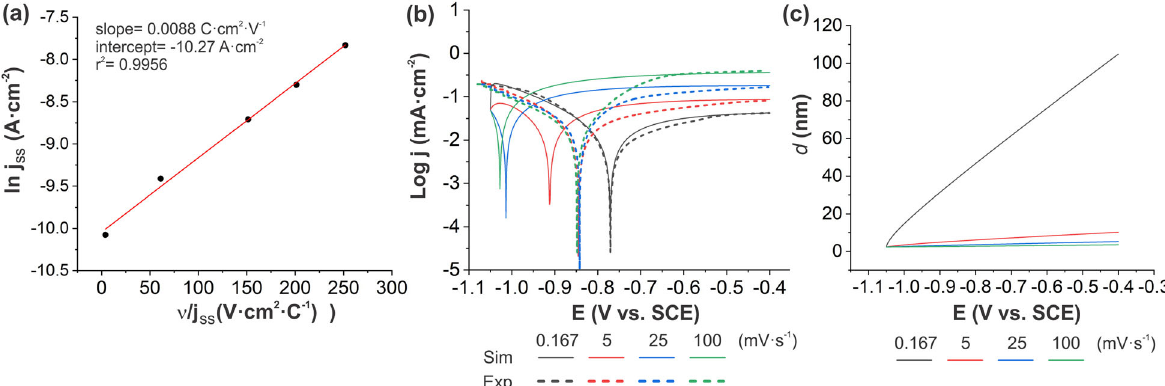
Fig. 8 Validation of A and β a values reported in literature. a Plot of ln( j ss ) vs. ν / j ss based on the values of j pdp at − 0.4 V for scan rates of 0.167, 5, 25, 50 and 100 mV·s − 1 in 0.62 M NaH 2 PO 4 . b Simulated PDP in 0.62 M NaH 2 PO 4 with A = 4.35 × 10 − 5 A·cm − 2 and β a = 5.17 × 10 − 7 cm·V − 1 obtained from ( a ). c Simulated d with the same A and β a in ( b ).